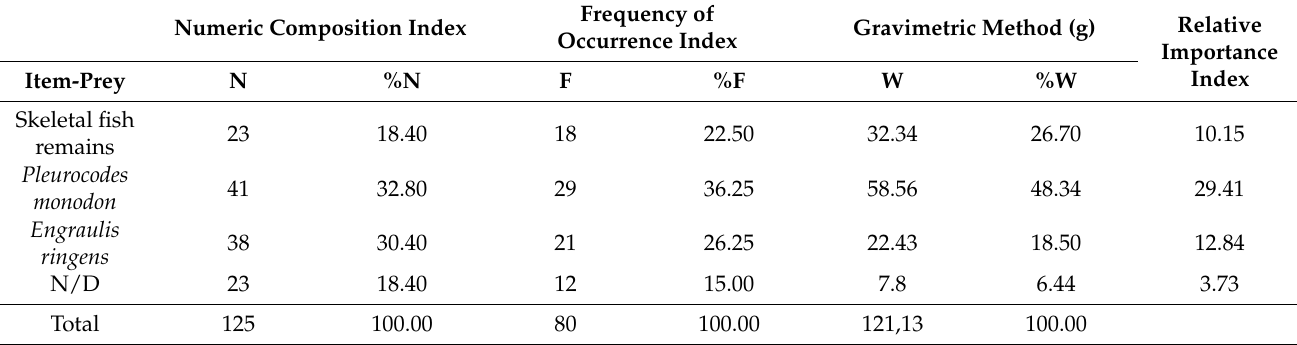
Table 2. Frequency of occurrence (%F), Numerical (%N), Gravimetric (%W) and Relative Importance Indexes (IIR) in stomach content for Sarda chiliensis chiliensis in the area of Pozo de Lisas.